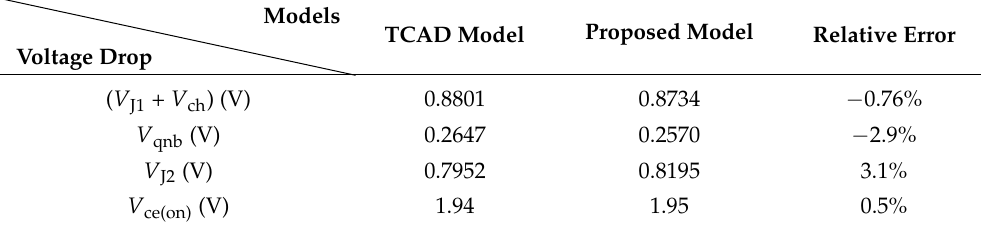
Table 4. Comparison of the through-state pressure drop in each part of the two